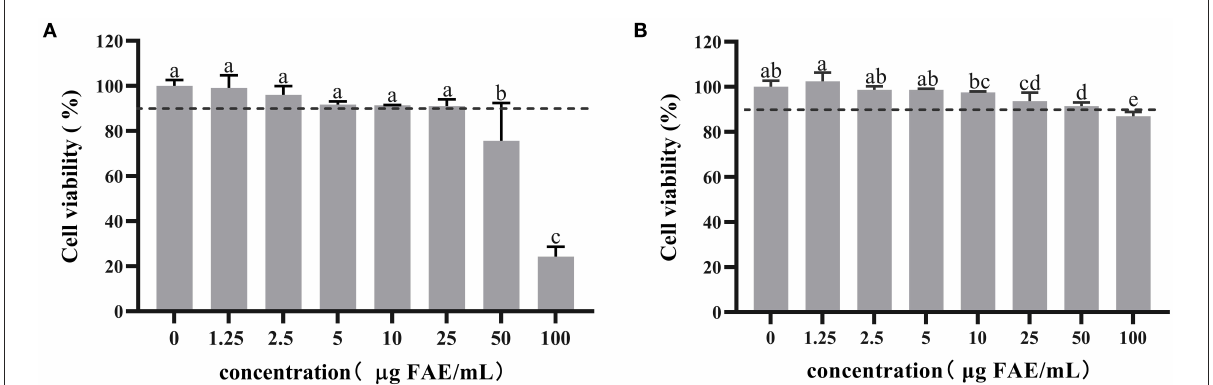
FIGURE2 Cytotoxicity of HBP extract on 3T3-L1 preadipocytes and mature adipocytes. (A) 3T3-L1 preadipocytes were differentiated with or without HBP extract for 24h. (B) 3T3-L1 mature adipocytes were treated or untreated with HBP extract for 24h. Cell viability was measured by MTT assay. Different letters indicate significant differences at p <